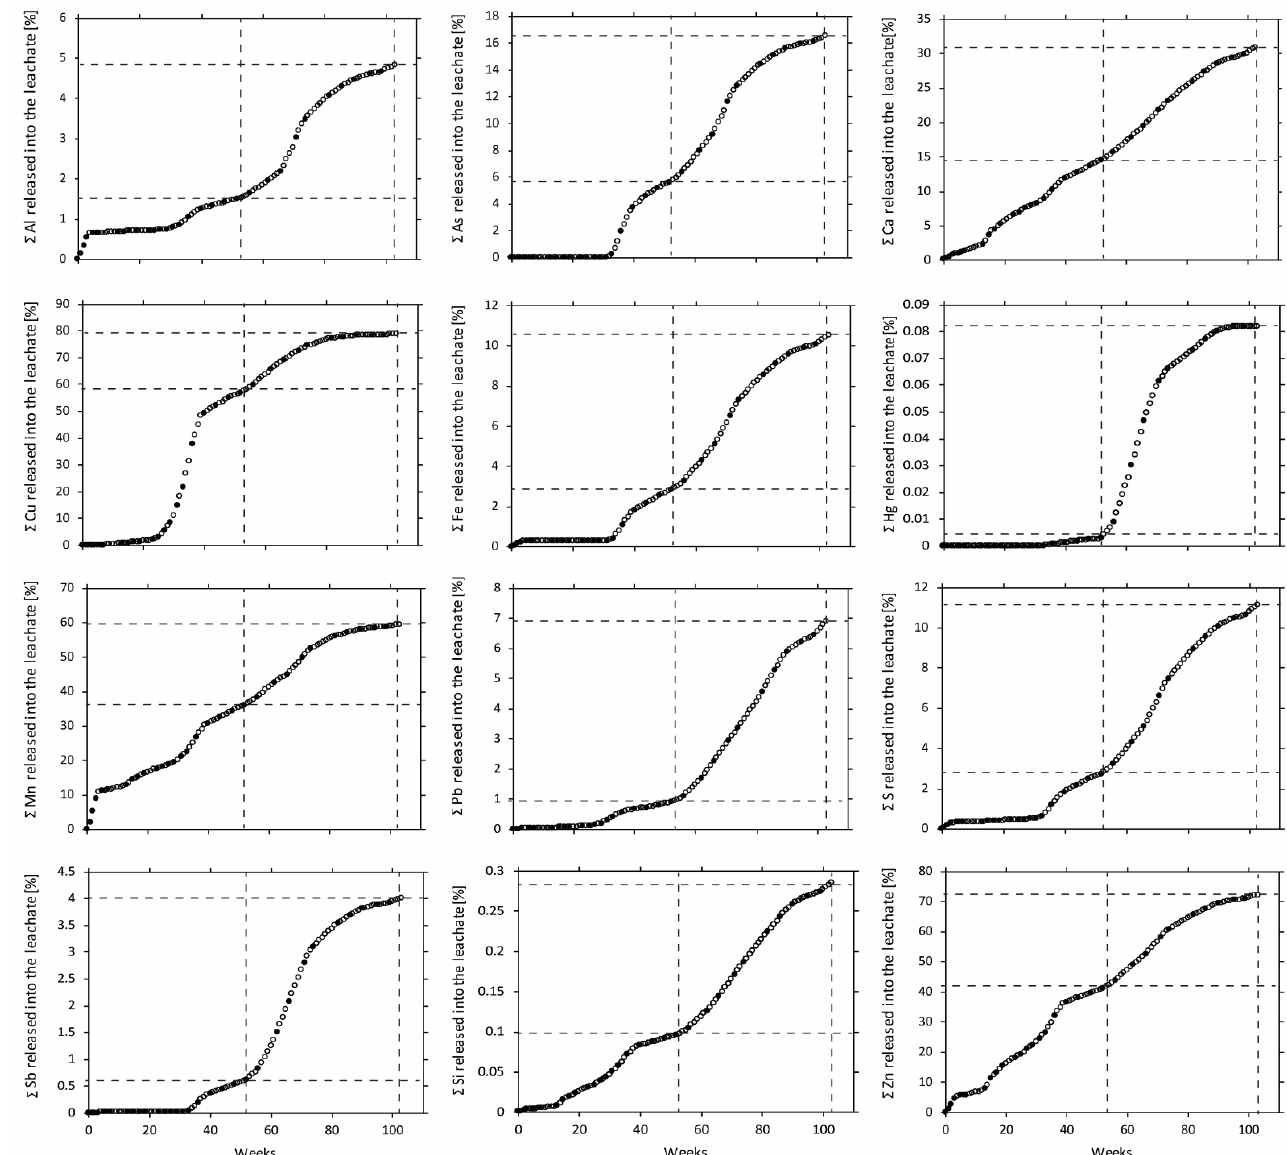
Figure 4. Estimated accumulated content of selected elements released into the leachate during 103 weeks of leaching the waste rock. The element content was calculated based on element concentrations reported by Nyström et al. [5] multiplied with the leachate volume withdrawn. Filled markings are actual measurements in the leachate. In contrast, outlined markings are estimated as the average between the two most adjacent actual measurements. Weeks 52 and 103 are marked with dashed vertical lines.